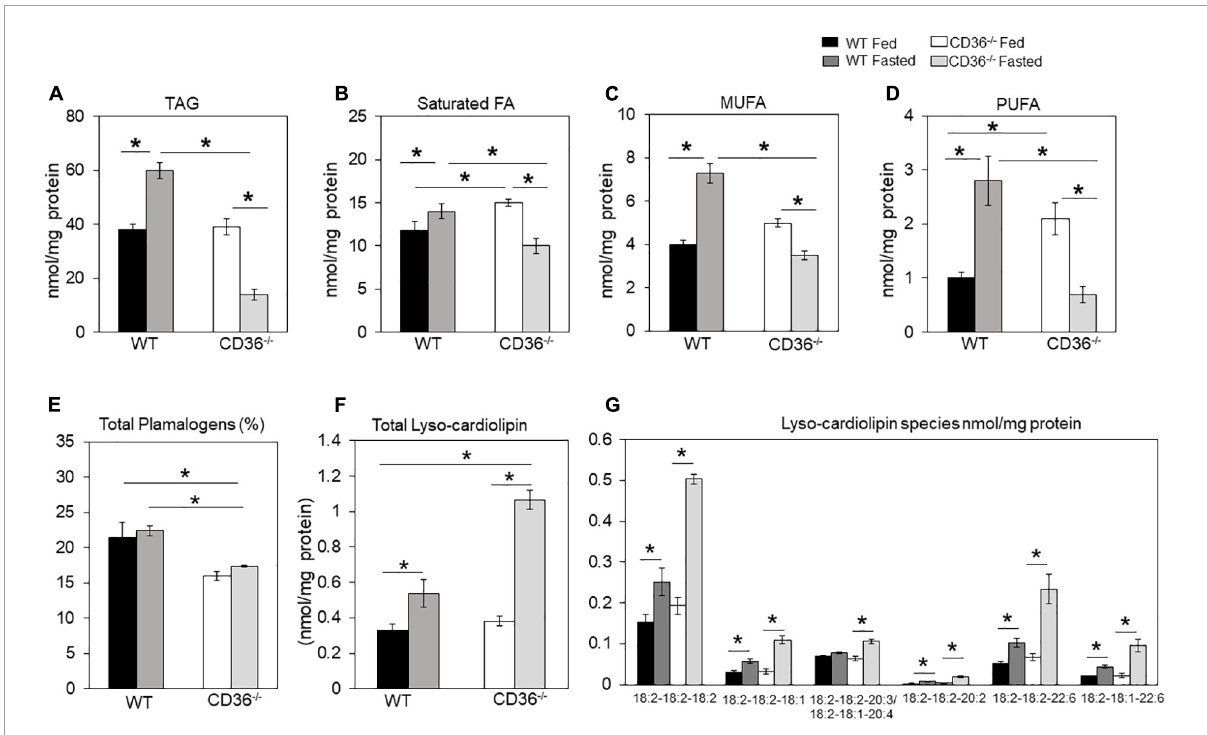
FIGURE1 CD36-mediated alterations in myocardial triglycerides and lysocardiolipin. Myocardial lipids in fed and fasted WT and CD36 − / − mice were analyzed using shotgun lipidomics mass spectrometry. Levels of (A) total triglycerides, (B) saturated, (C) monounsaturated (MUFA), and (D) polyunsaturated (PUFA) FAs in TGs. (E) Levels of total plasmalogens (%). (F) Levels of lysocardiolipins. (G) Lysocardiolipin species. Labels denote the number of carbons: number of double bonds. Results are reported as nmol/mg of protein. Data ( n = 5/group) are means ± SE with n representing the number of mice per group, * p <